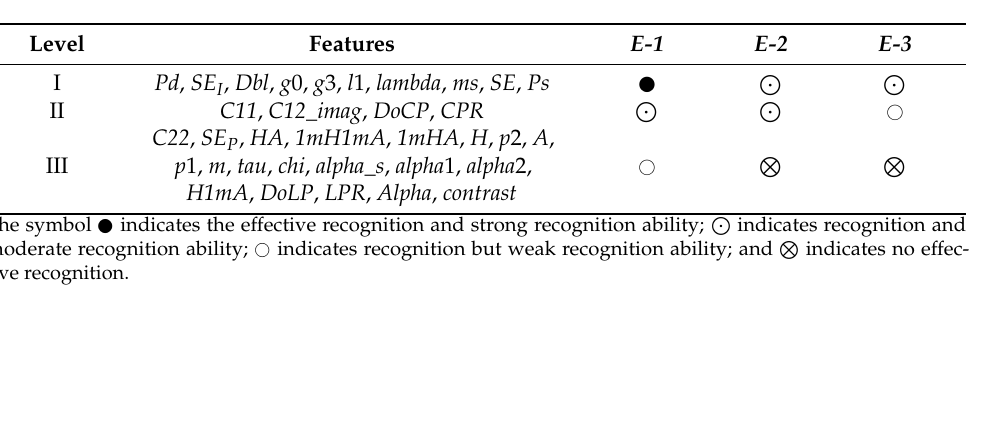
Table 3. Visualization of “white” eddies with CP